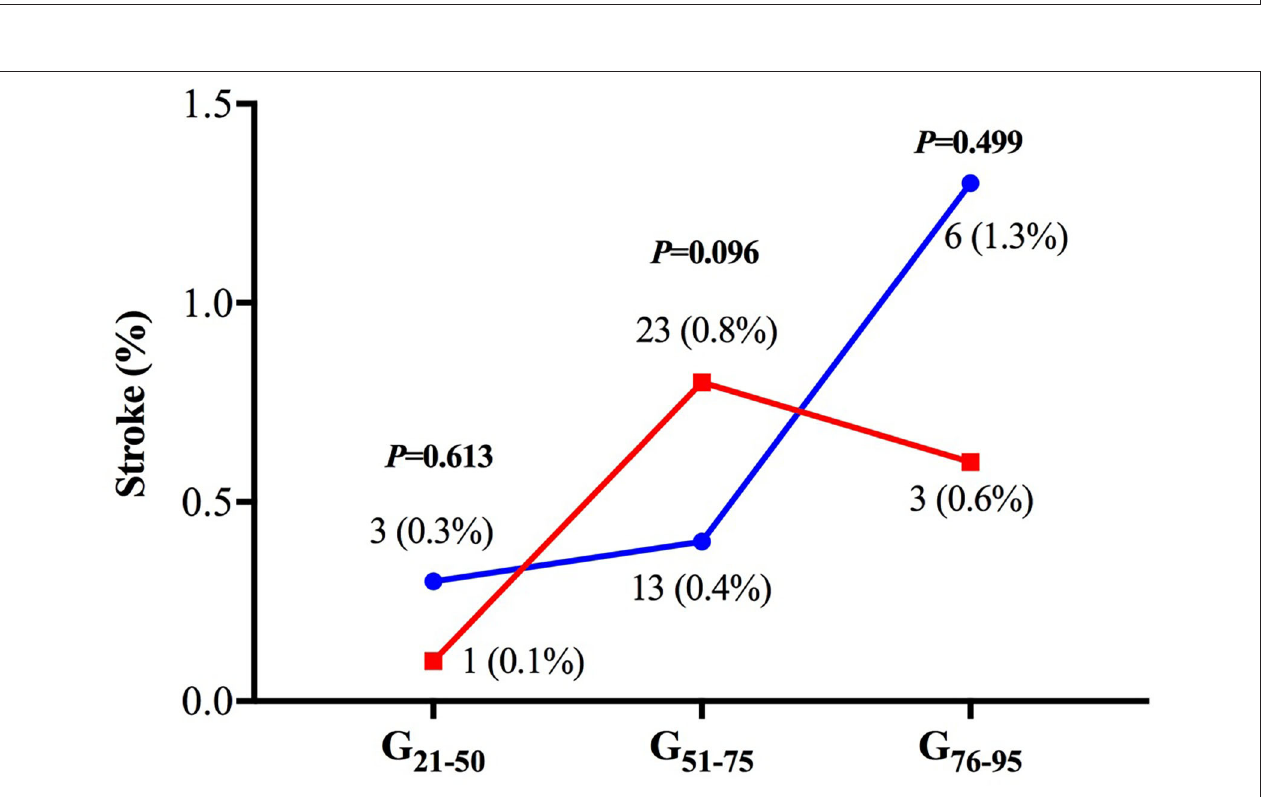
Frontiers in Cardiovascular Medicine |